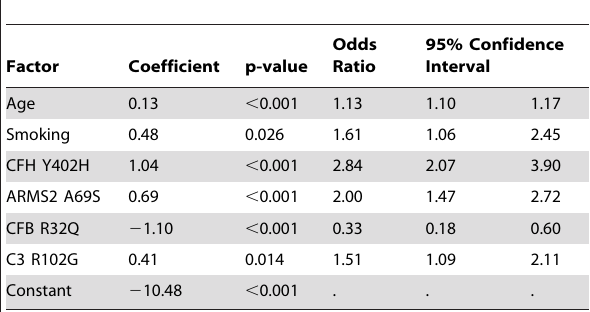
Table 3. Logistic regression model in the VM training dataset.